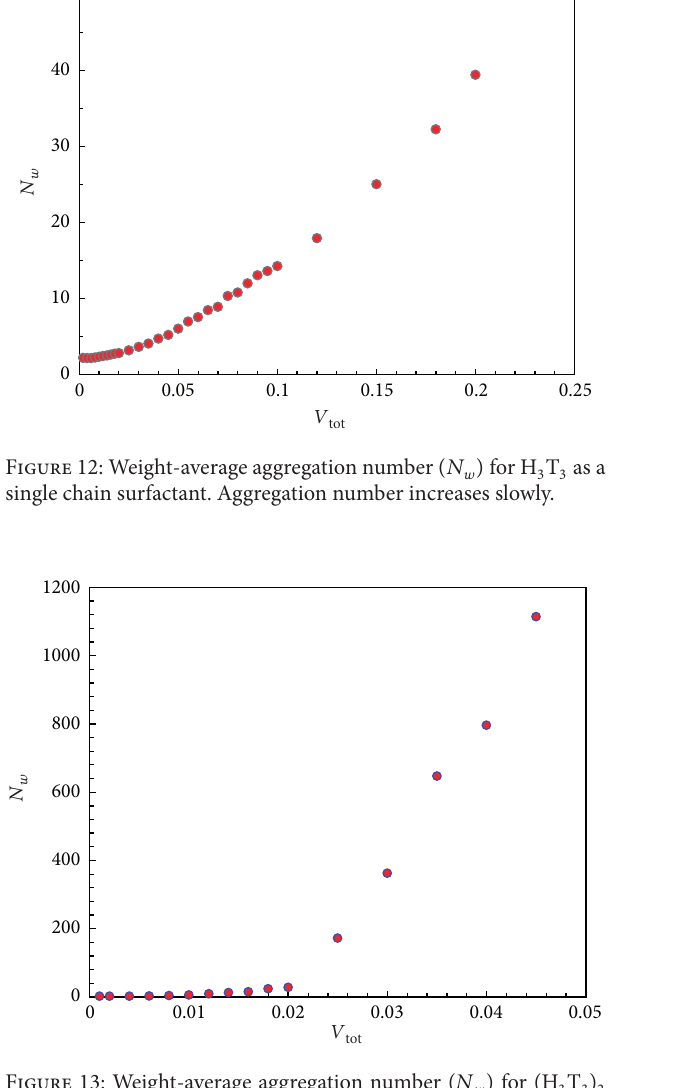
F 14: Structure of aggregates of (H ) (a)0.016,(b)0.02,and(c)0.07.estructuresshowthatheadgroups of the molecule (green beads) play a connector role to join separate micelles. At high concentrations bolaform micelles are